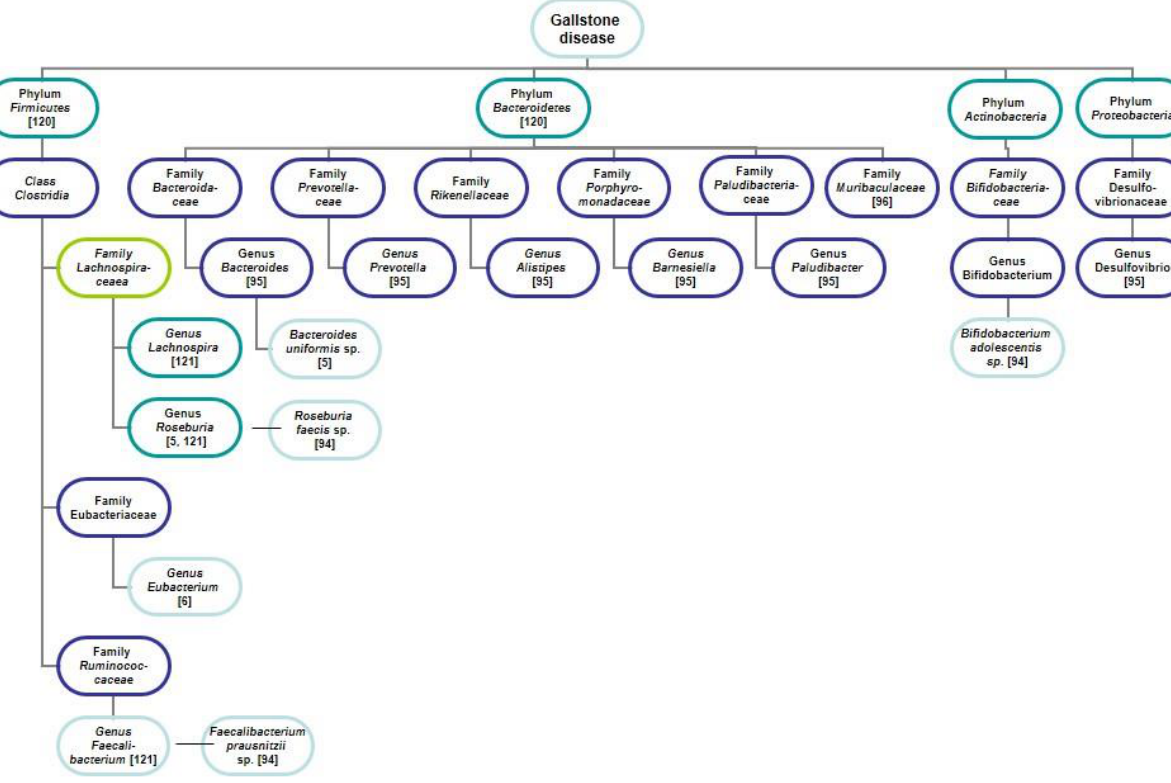
Figure 2. Characteristics of the gut microbiome of patients with GSD. A significant decrease of the phyla Firmicutes , Actinobacteria , Proteobacteria , and Bacteroidetes is reflected. The number in square brackets indicates a reference in the list of references.